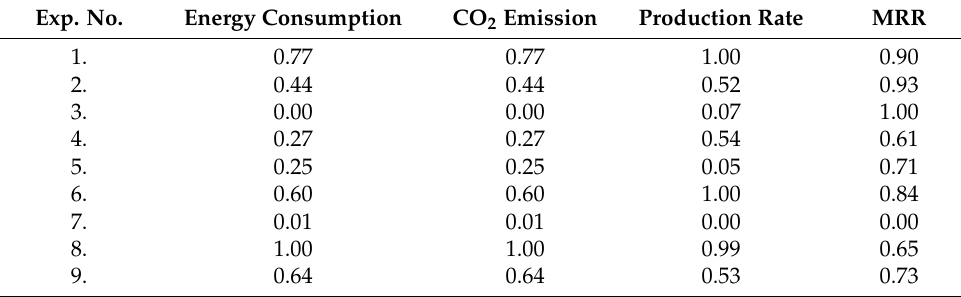
Table 6. Grey relational co-efficient and Grey relational grade.